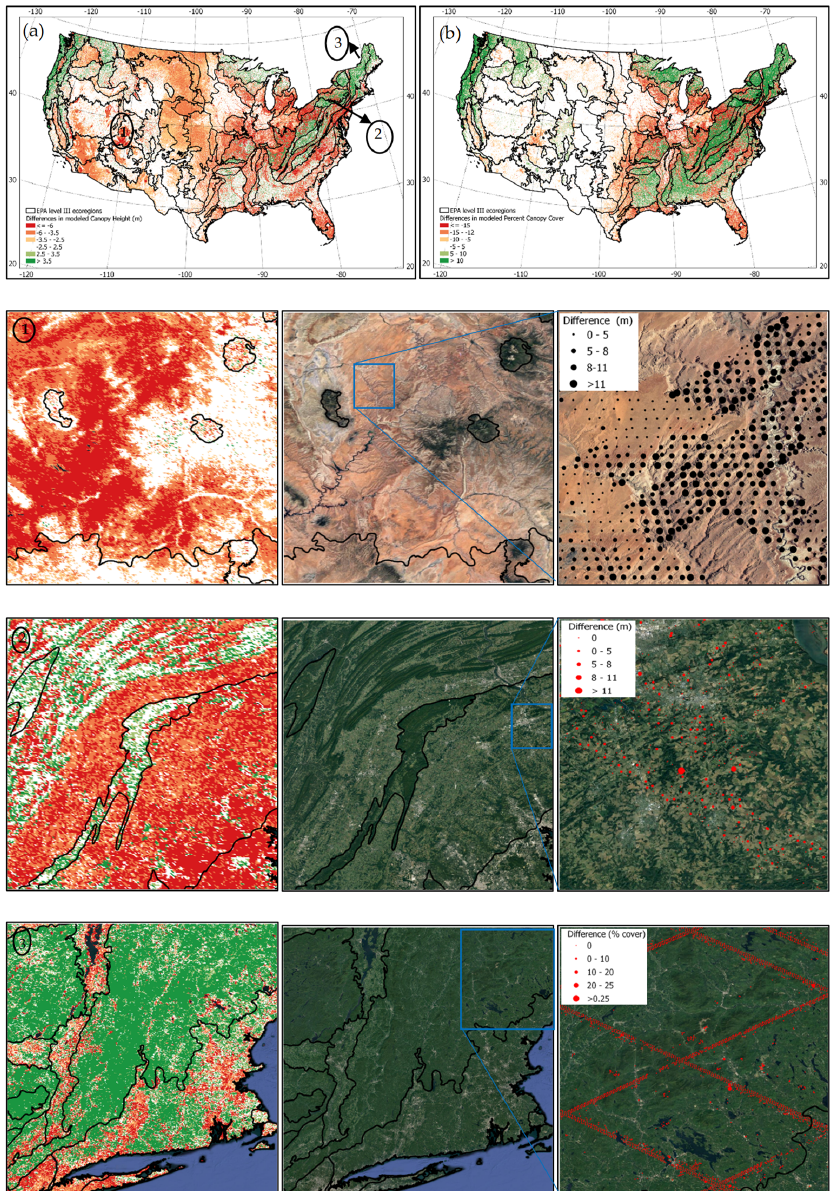
Figure 8. ( a ) A difference map between the 2019 canopy height produced in this study and the 2019 canopy height map in Rishmawi et al. (2021). Red shades indicate areas in this study with lower derived canopy height values (inset ① ) while green shades in inset ② show areas with comparatively higher canopy height values. ( b ) Is the same as in ( a ) but for percent canopy cover. From left to right: panel ① shows significant improvements in modeling canopy height in barren areas that can be attributed to the corrections applied to the GEDI canopy height data (black circles); panel ② shows improvements in modeling canopy height in agricultural areas with field crop height values ~ 0 m in the current study; and ③ shows for the densely forested landscapes higher canopy cover (green areas) values than in Rishmawi et al. (2021).